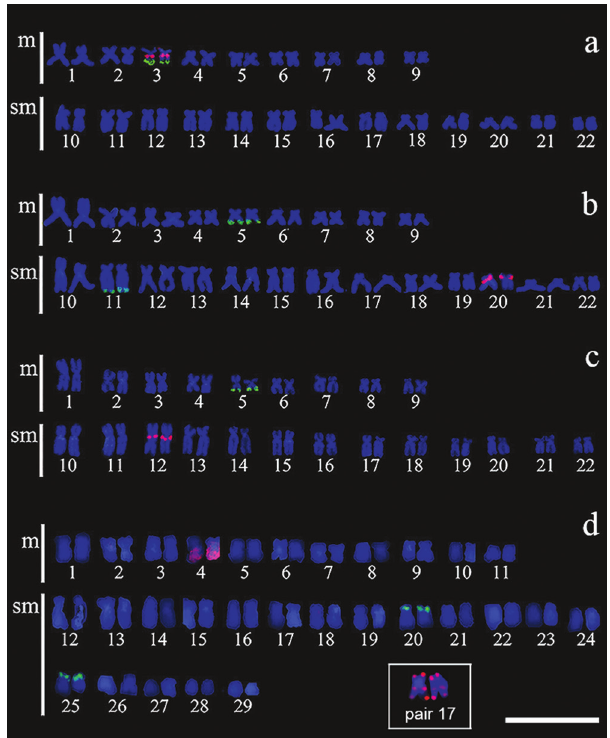
Fig. 3. Karyotypes of the Corydoras species subjected to two-color FISH with 18S rDNA probes (green) and 5S rDNA probes (red): (a) C. ehrhardti (Verde River), (b) C. aff. paleatus (Iguaçu River), (c) C. aff. paleatus (Areia stream), and (d) C. lacrimostigmata (Barra Grande River). In detail, the chromosome pair of C. lacrimostigmata (Barra Grande River), carrier of ITS. Scale bar = 10